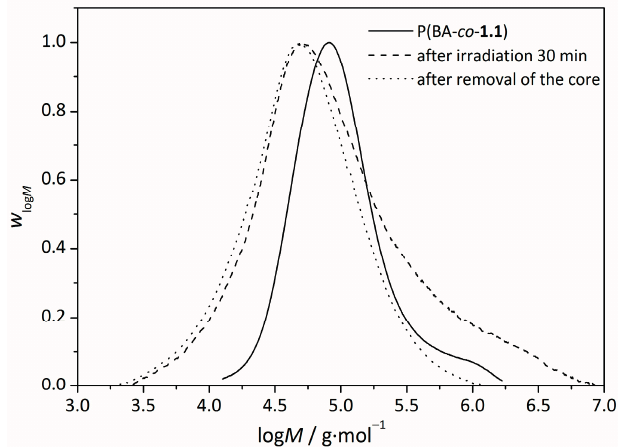
Figure 12. SEC-traces of star (BA 62 - co - 1.1 38 ) before irradiation (solid), after irradiation (dashed) and after de-coring by aminolysis with an excess of butyl amine and catalytic